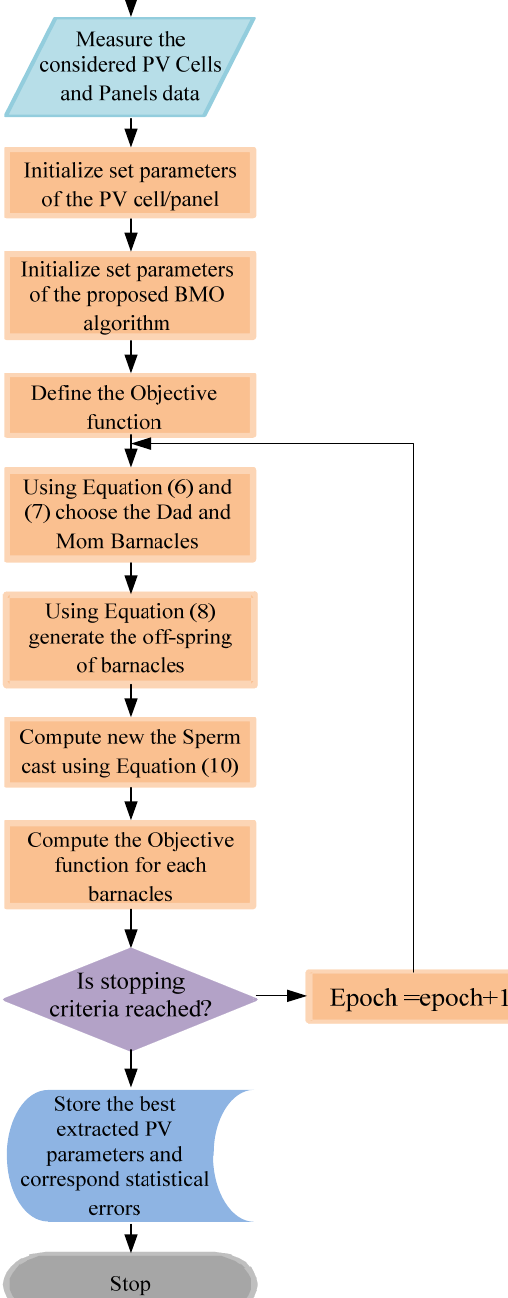
Figure 1. Proposed BMOA-based PV cell and panel parameters extraction pictorial overview.